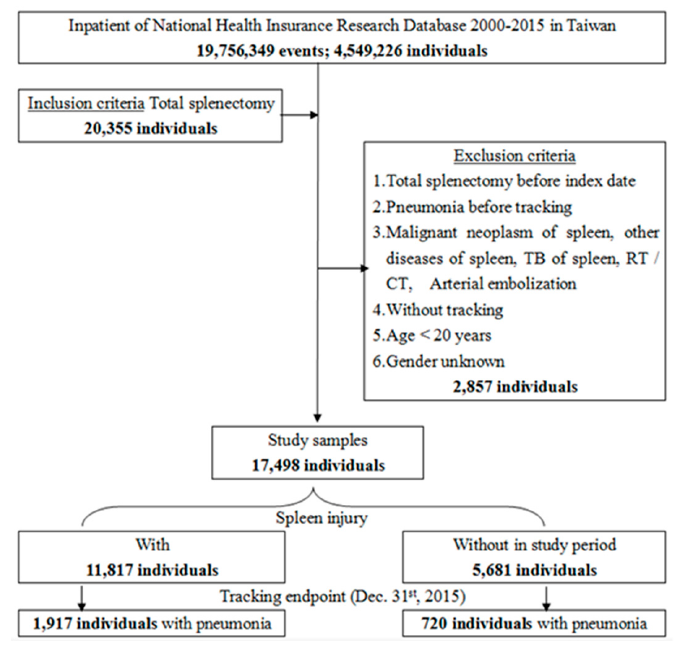
Figure 1. The flowchart of study sample selection and design.